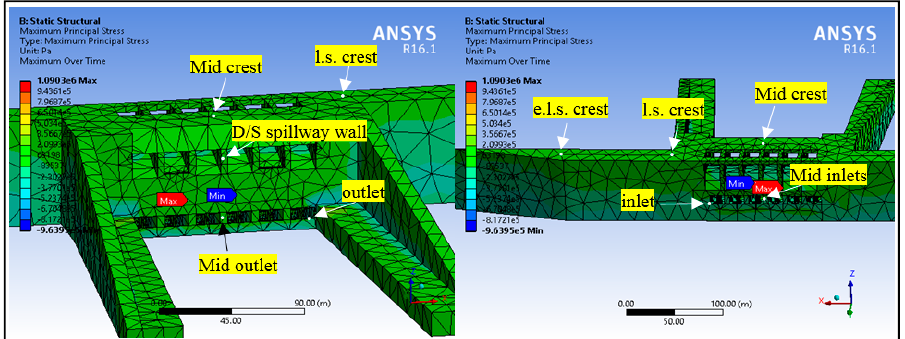
Figure 8. The selected points to measure the principal stress and its distribution in the concrete part of Haditha dam in maximum drawdown with six turbines operating.